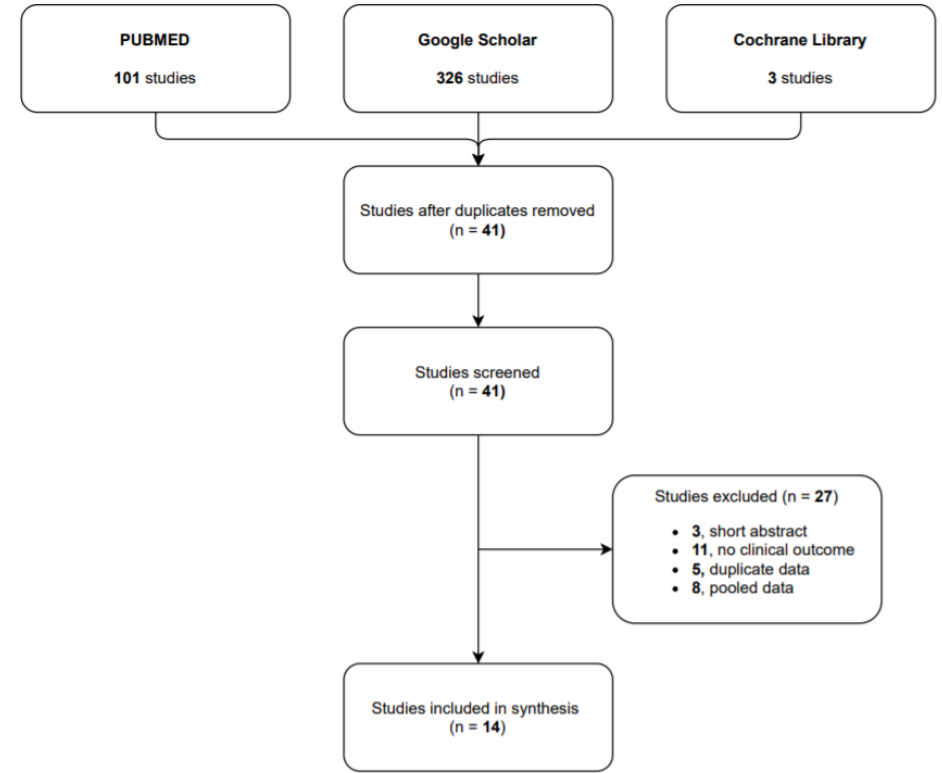
Figure 1. Flow diagram study selection process.